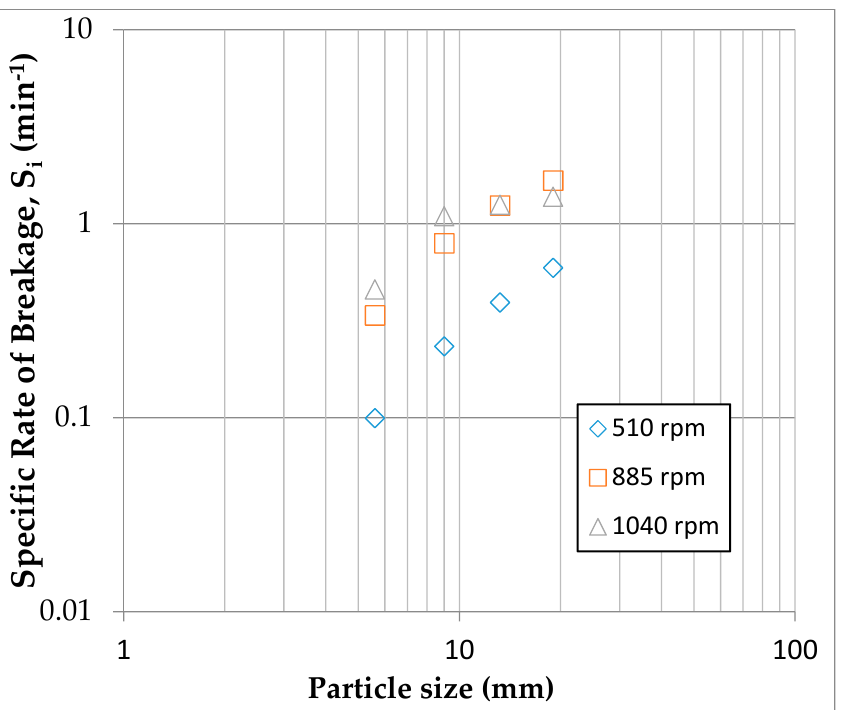
Figure 4. Variation of the selection function with particle size for different speeds.